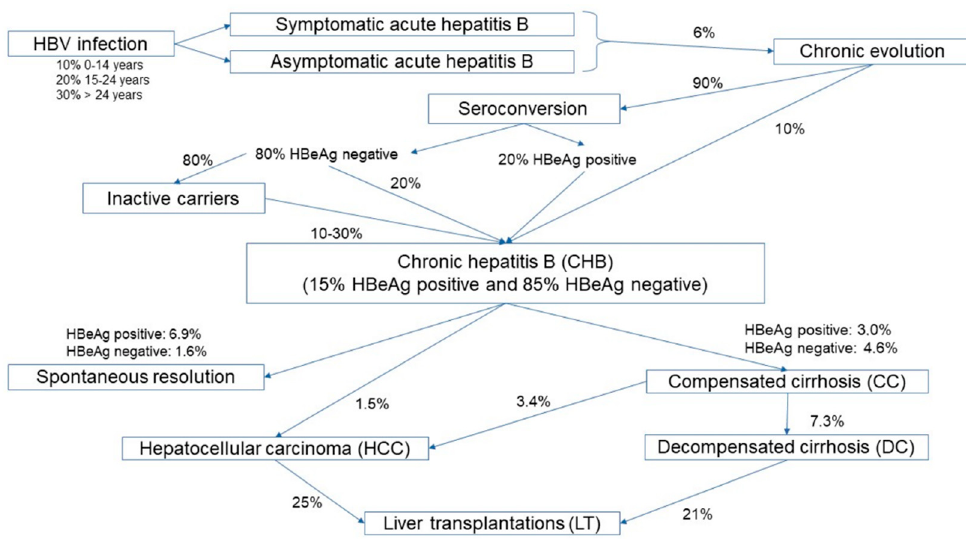
Figure 1. Natural history of HBV infection applied to the mathematical model. Epidemiological and economic data included in the model have been obtained or updated from the previous study led by Boccalini et al. [12]. In particular, data related to the population by age group [13], life expectation [14], acute-hepatitis-B incidence rates [9], prevalence of HBsAg-positive mothers [15–17] anti-HBV vaccine coverage (VC) values [18] and inflation rates [19], were